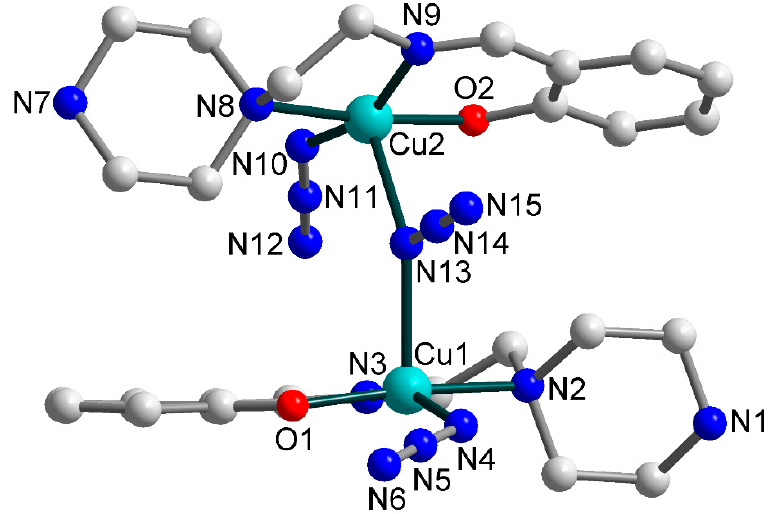
Figure 2. Molecular structure of 1 (building unit) with the atom numbering scheme. H atoms and uncoordinated water molecules are omitted for clarity. Colour scheme: Cu, cyan; O, red; N, blue; C, grey.